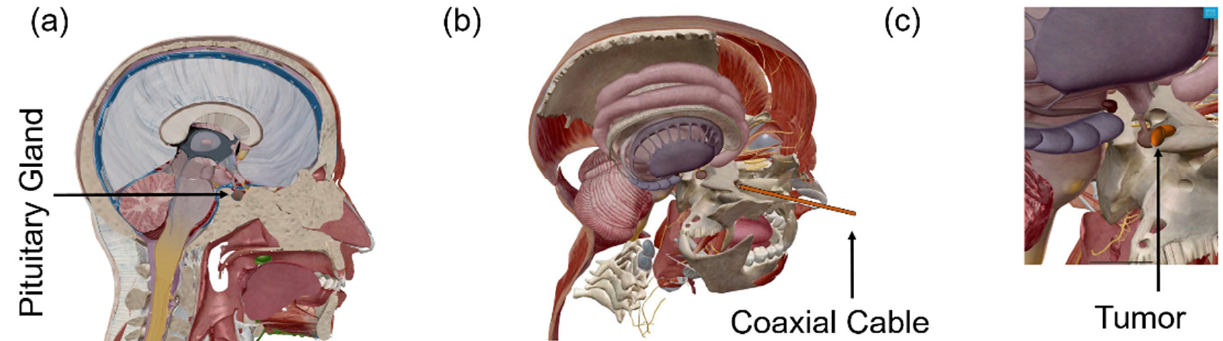
Figure 1. ( a ) Anatomical detailed 3D view of a sagittal section of a physiological human head, taken from Visible Body (https://www.visiblebody.com/, accessed on 15 January 2022). ( b ) Three- dimensional rendering of the trans-sphenoidal endoscopic surgical approach, typically used in clinical practice. Some biological structures were removed to increase visibility. ( c ) Zoom of the pituitary gland affected by a tumor.